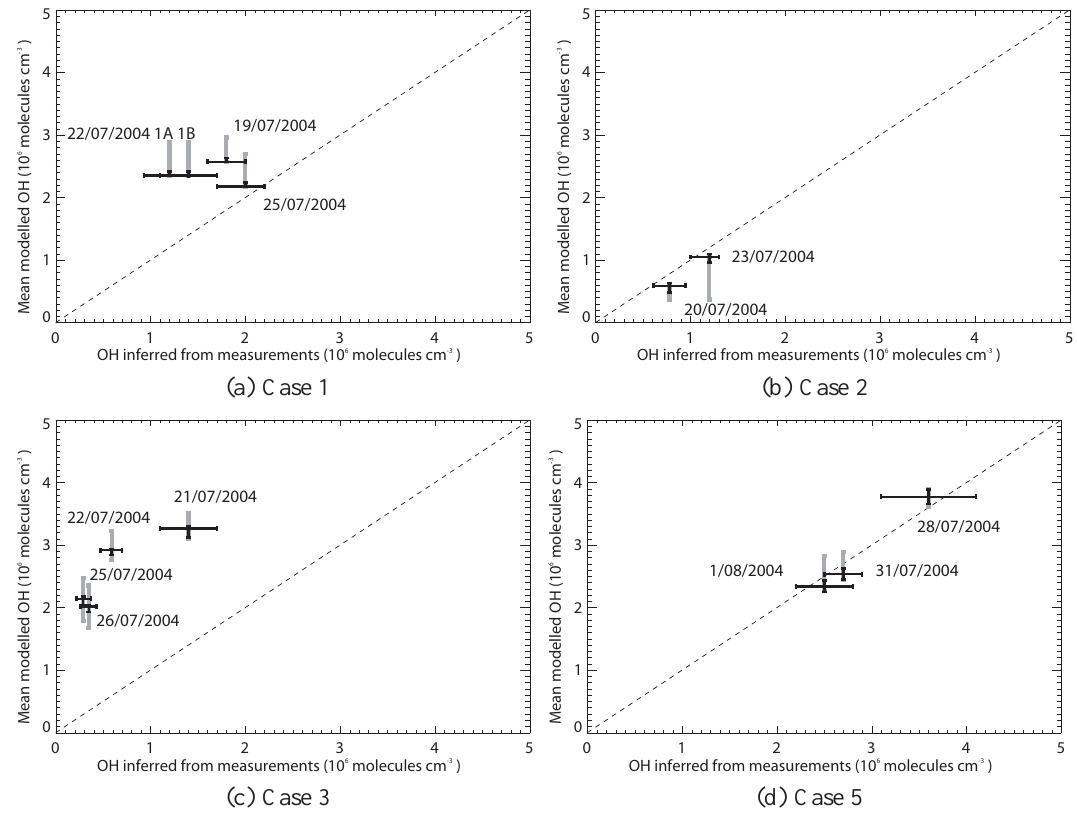
Fig. 6. Comparison of modelled [ OH ] with that inferred from hydrocarbon measurements by Arnold et al. (2007). The 25th and 75th Fig. 6. Comparisonofmodelled [ OH ] withthatinferredfromhydrocarbonmeasurementsbyArnold percentiles were calculated from the time-average OH along the trajectories within each ensemble. The black bars show the resulting range etal.(2007). The25thand75thpercentileswerecalculatedfromthetime-averageOHalongthetrajec- for the control ensemble (doubled dry deposition for case 3). The grey bars show the minimum and maximum of the results from all sensitivity torieswithineachensemble. Theblackbarsshowtheresultingrangeforthecontrolensemble(doubled experiments. Ensemble results are filtered such that only trajectories that reach the final Lagrangian match location are included drydepositionforcase3).Thegreybarsshowtheminimumandmaximumoftheresultsfromallsensi- tivityexperiments.EnsembleresultsarefilteredsuchthatonlytrajectoriesthatreachthefinalLagrangian matchlocationareincludedhere. 49